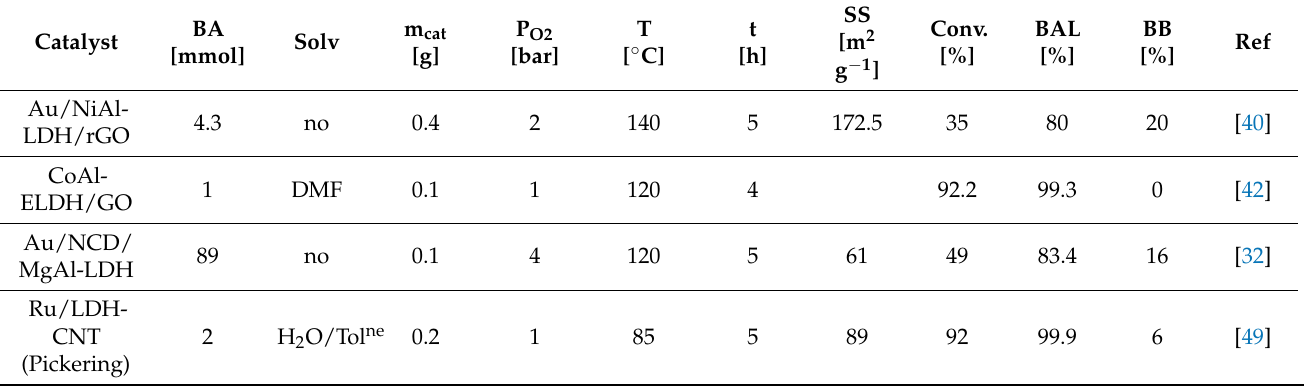
Table 4. Conditions of reaction and results of aerobic oxidation of BA over different nanocompo- site